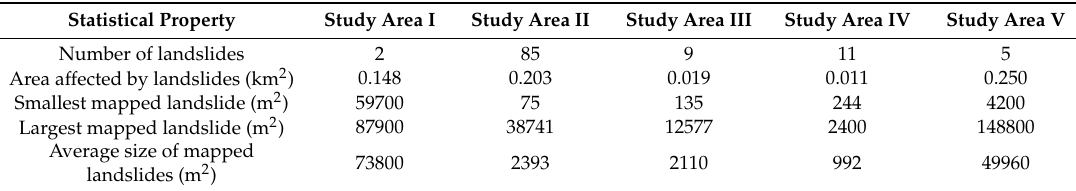
Table 5. Statistics of the OBIA mapping results for each of the five study areas.